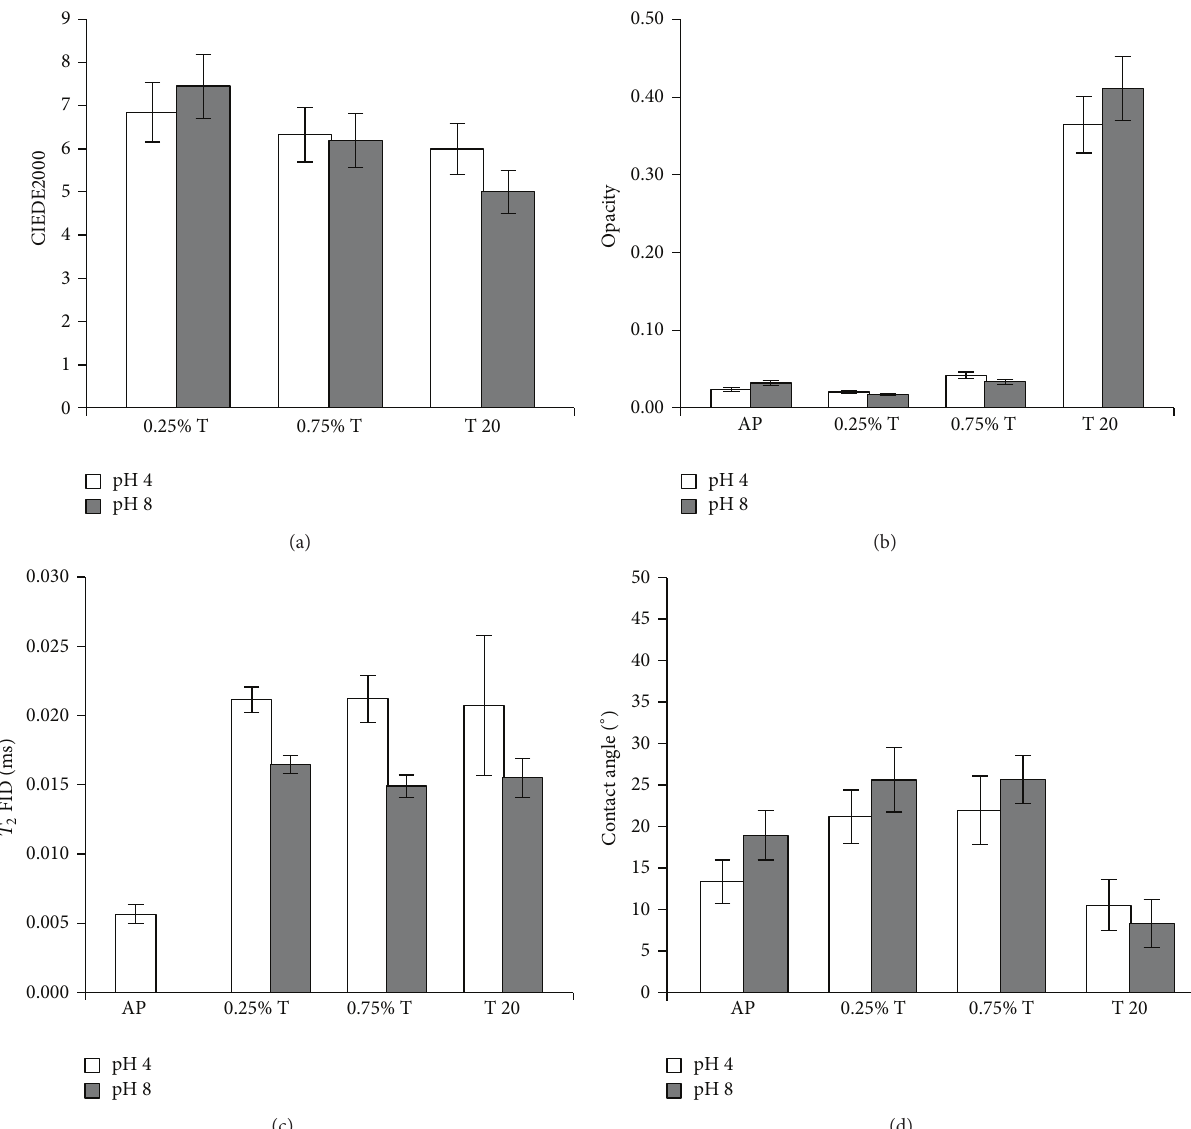
Figure 2: Characterization of each film at initial time at different pH: (a) variation of color (CIEDE2000), (b) opacity, (c) molecular mobility by 𝑇 2 FID, and (d) contact angle. Bars correspond to standard deviation of mean value. 0.25% T: 0.25% w/w trehalose; 0.75% T: 0.75% w/w trehalose; T 20: 1% w/w Tween